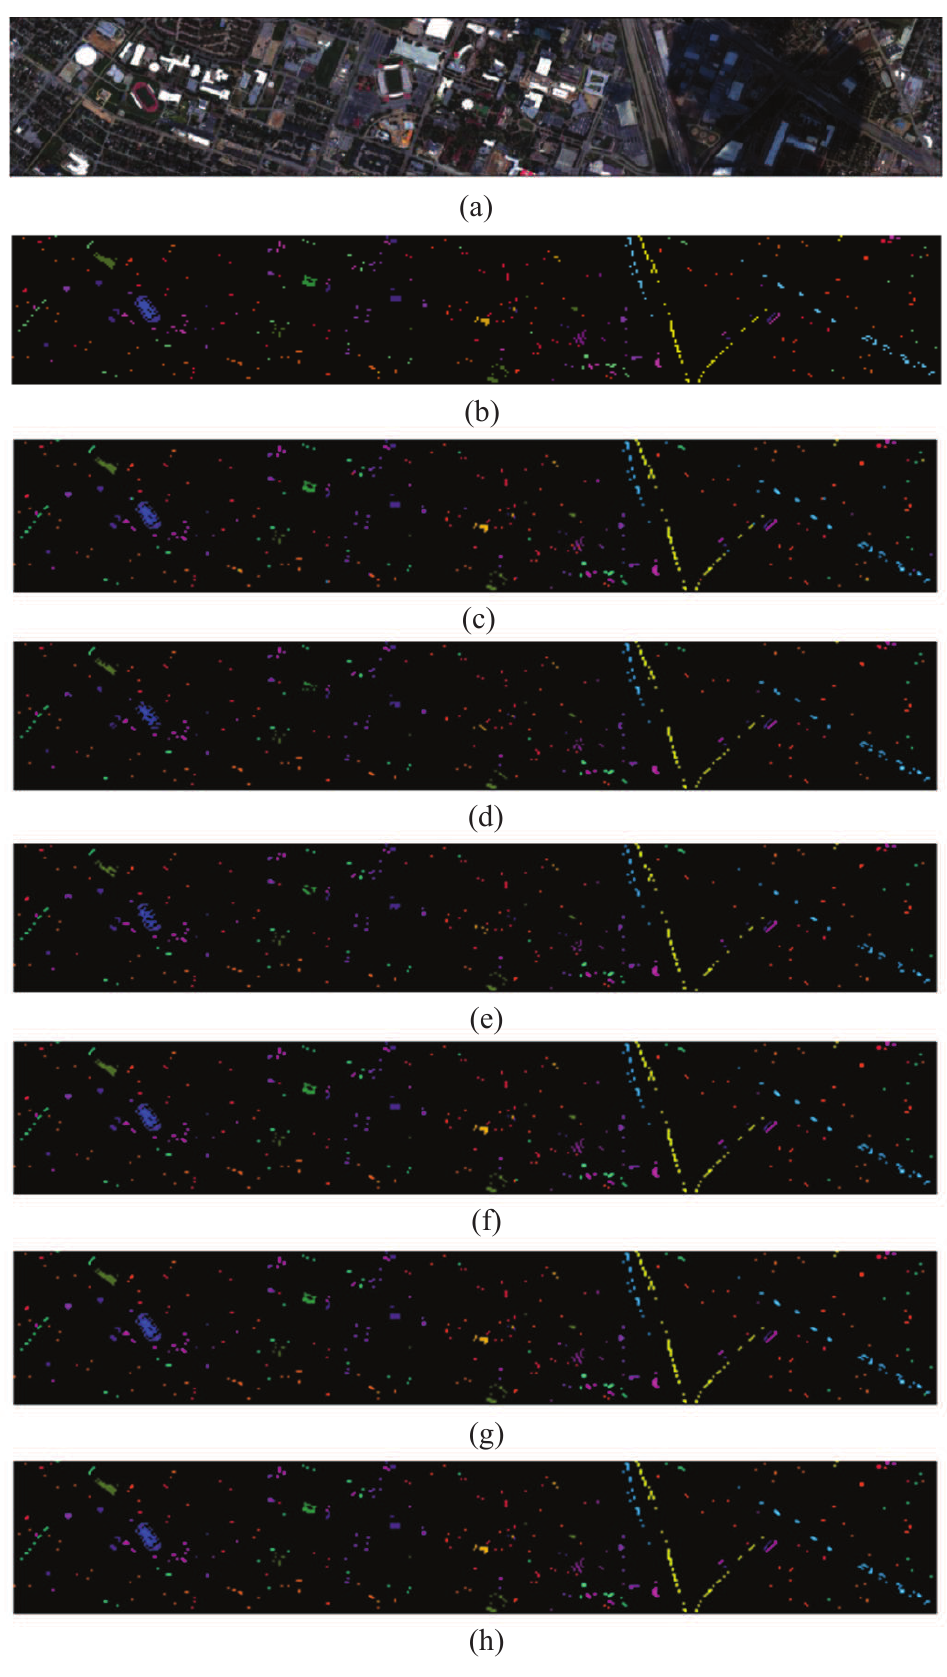
Figure 12. Classification maps provided for the Grss_dfc_2013 data set by different methods. ( a ) A false color map ( b ) The ground truth map ( c ) CNN (94.59%). ( d ) M3DCNN (99.10%). ( e ) SSRN